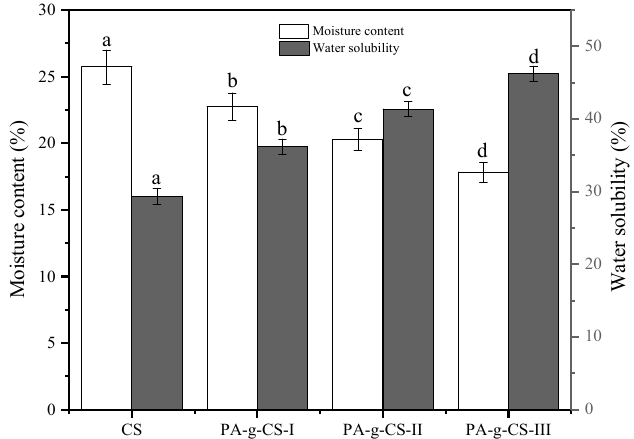
Figure 4. Moisture content and water solubility of the CS and PA-g-CS (I-III) films. Different letters in the same index indicate a significant difference ( p < 0.05).